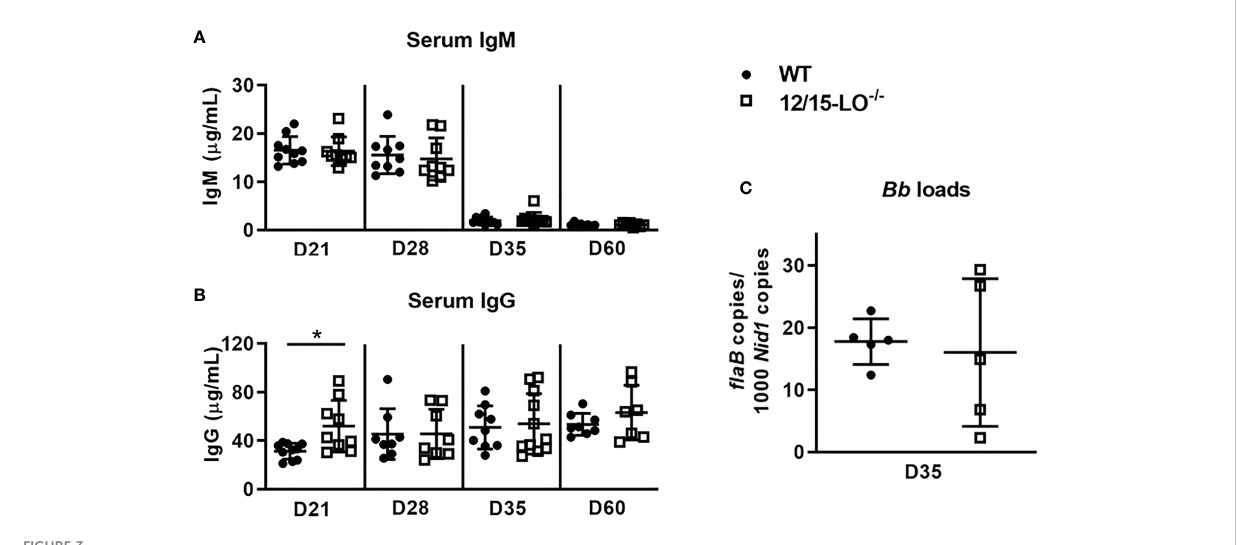
FIGURE 3 12/15-LO de fi ciency does not affect the anti- Borrelia immune response. C3H WT and 12/15-LO -/- mice were infected with B. burgdorferi and sacri fi ced on the indicated dpi. Blood was collected and B. burgdorferi -speci fi c serum IgM (A) and IgG (B) levels were determined by ELISA. n=7-10/ group. *p<0.05 by t-test between strains per timepoint. (C) B. burgdorferi loads in ankles at D35 by qPCR.